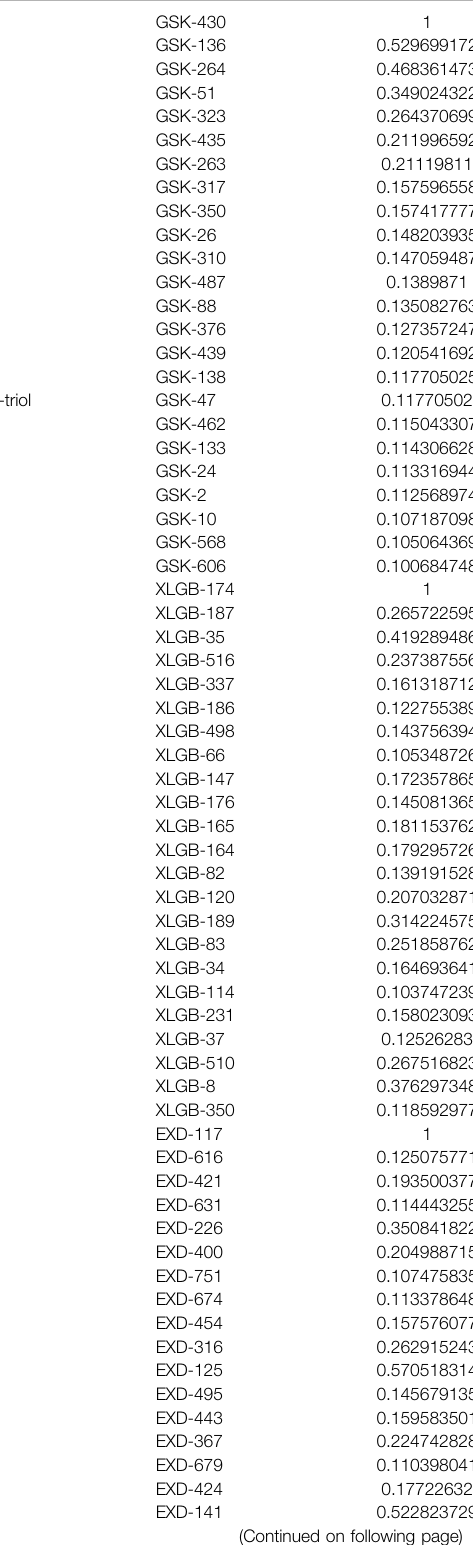
TABLE 3 | The potential important components and score in GSK, XLGB, and EXD.